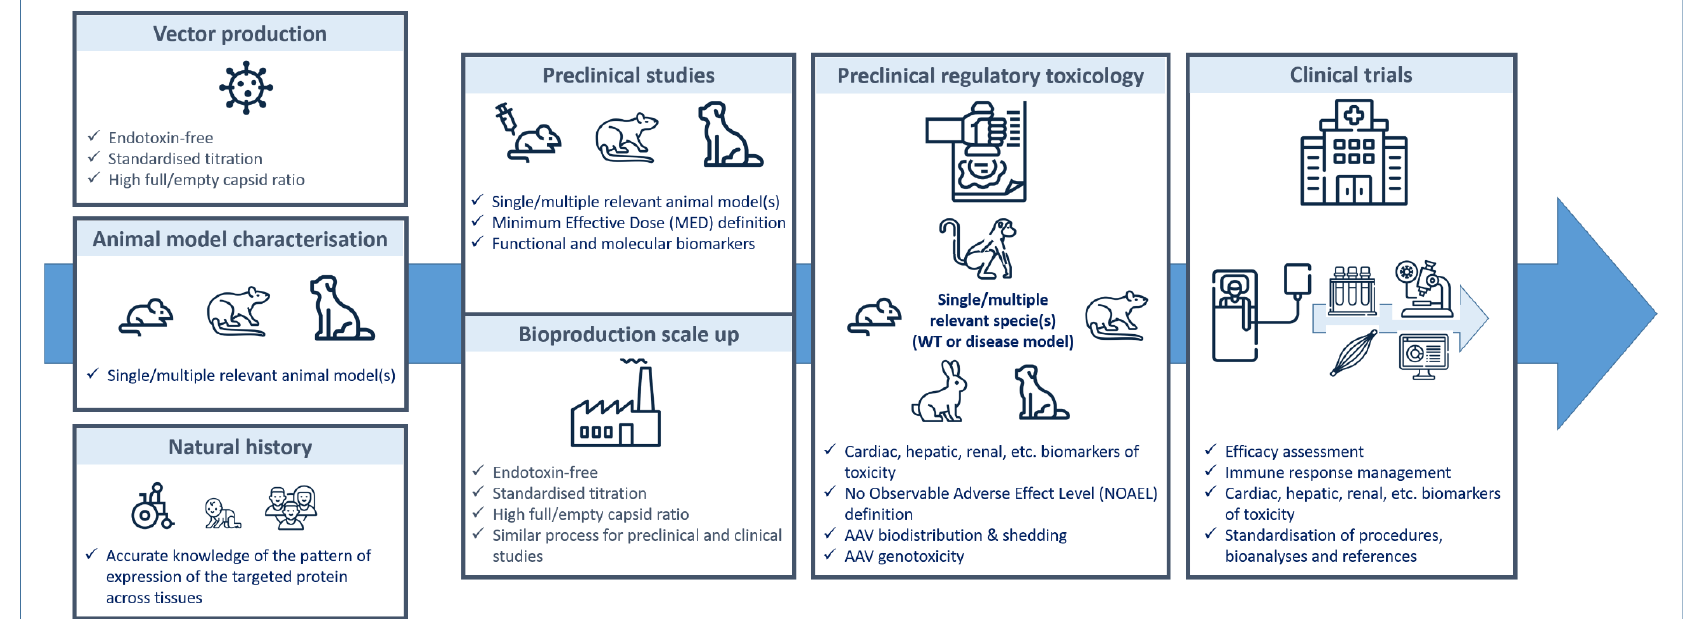
Figure 1. Of rAAV and men: the ideal journey.